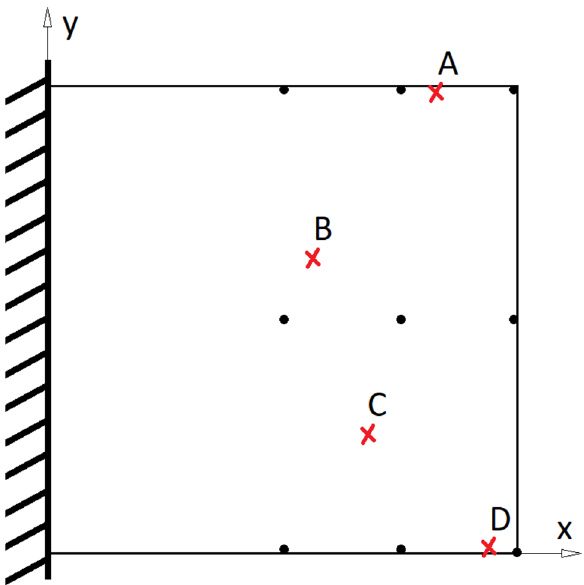
Fig. 11 Location of arbitrary test points A to D on a coarser calibra- tion grid